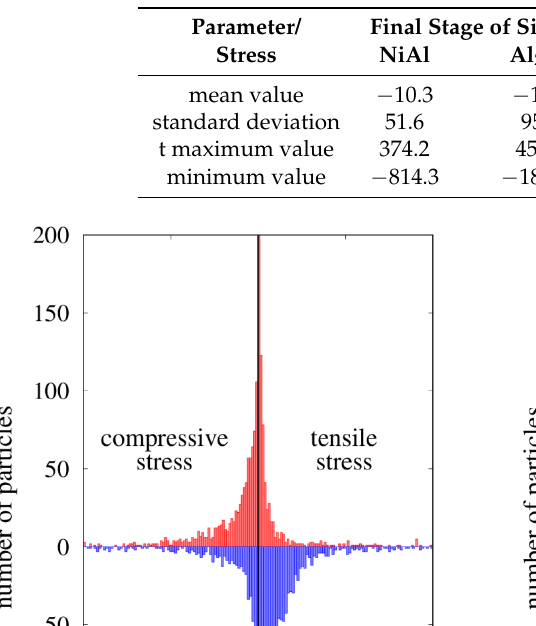
Statistical parameters of particle total hydrostatic stresses [MPa] of each phase in NiAl/Al 2 O 3 specimen.